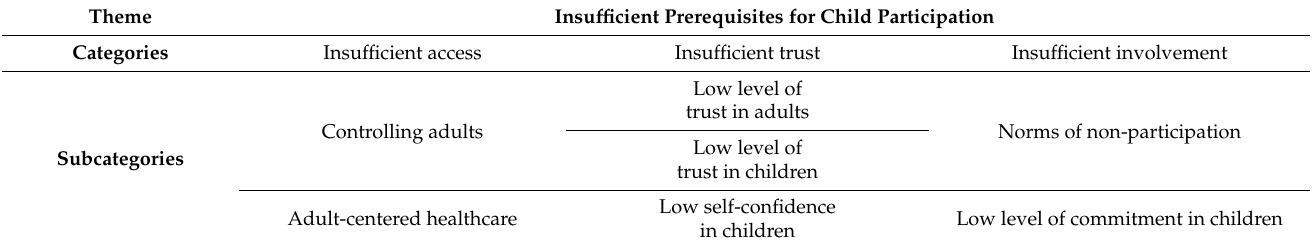
Table 2. Barriers to participation according to children and young people with disabilities, parents, and professionals.